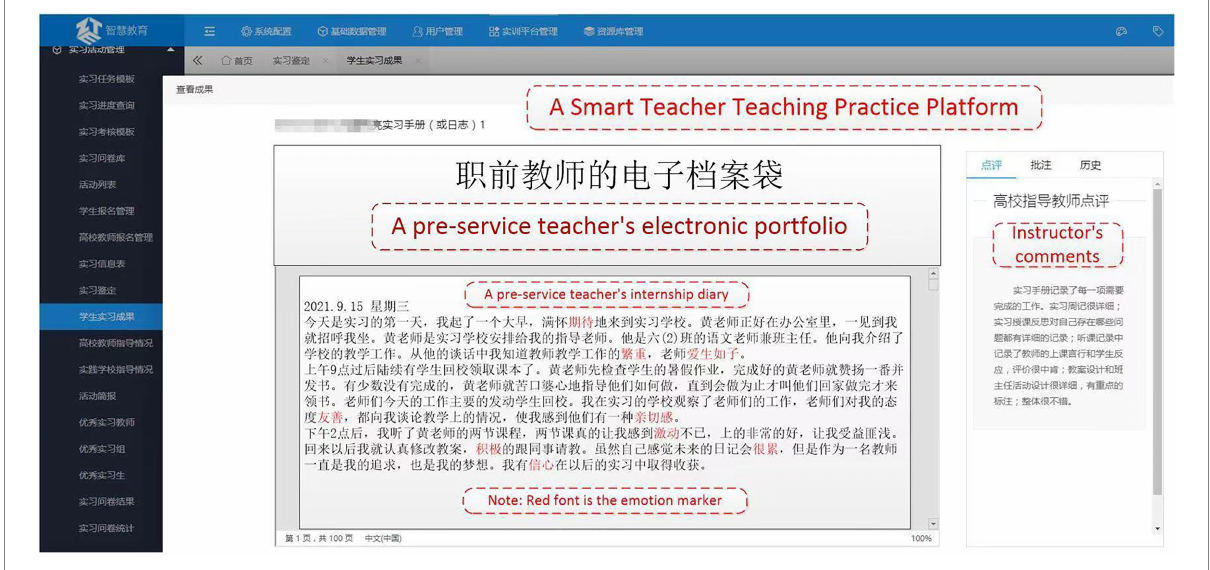
FIGURE 1 A smart teacher teaching practice platform.